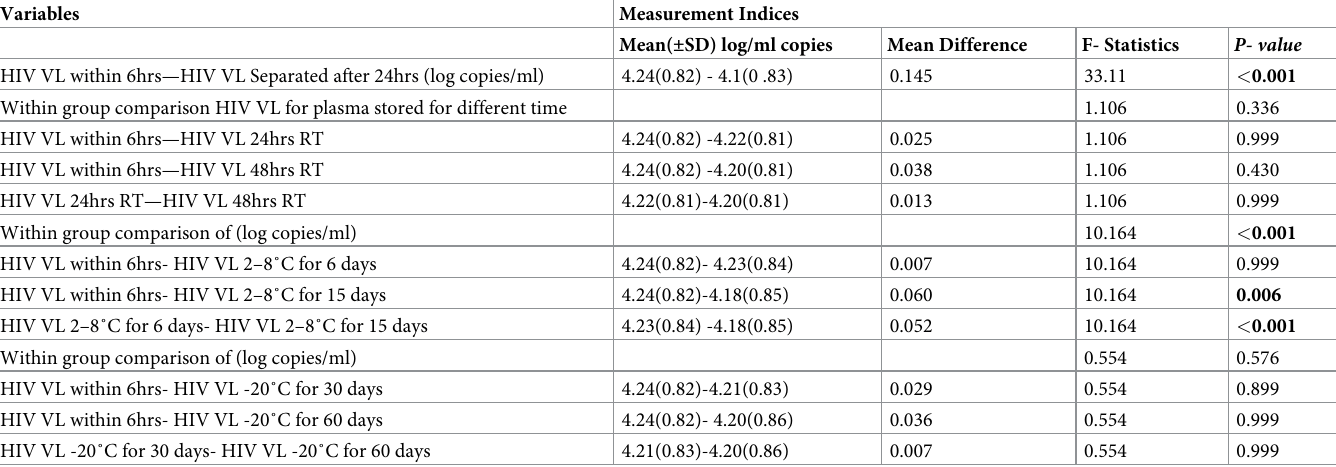
Table 2. Repeated measurement analysis of variance in log/ml for each plasma separation time, storage at room temperature, 2–8˚C and -20˚C.